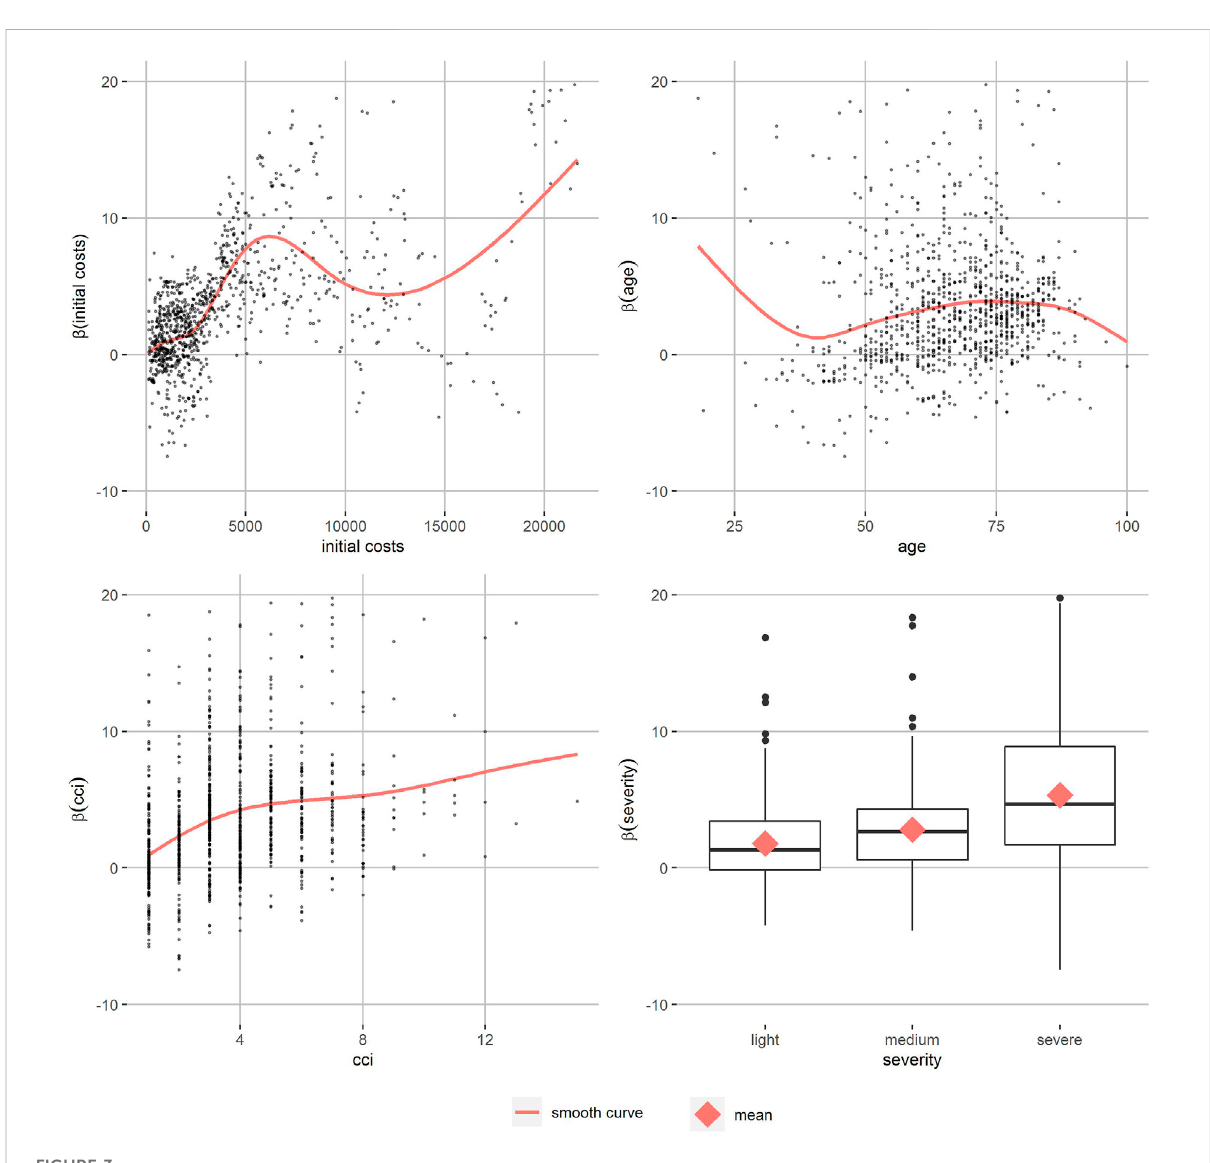
FIGURE 3 Partial dependence plots of T2D patients with high level of